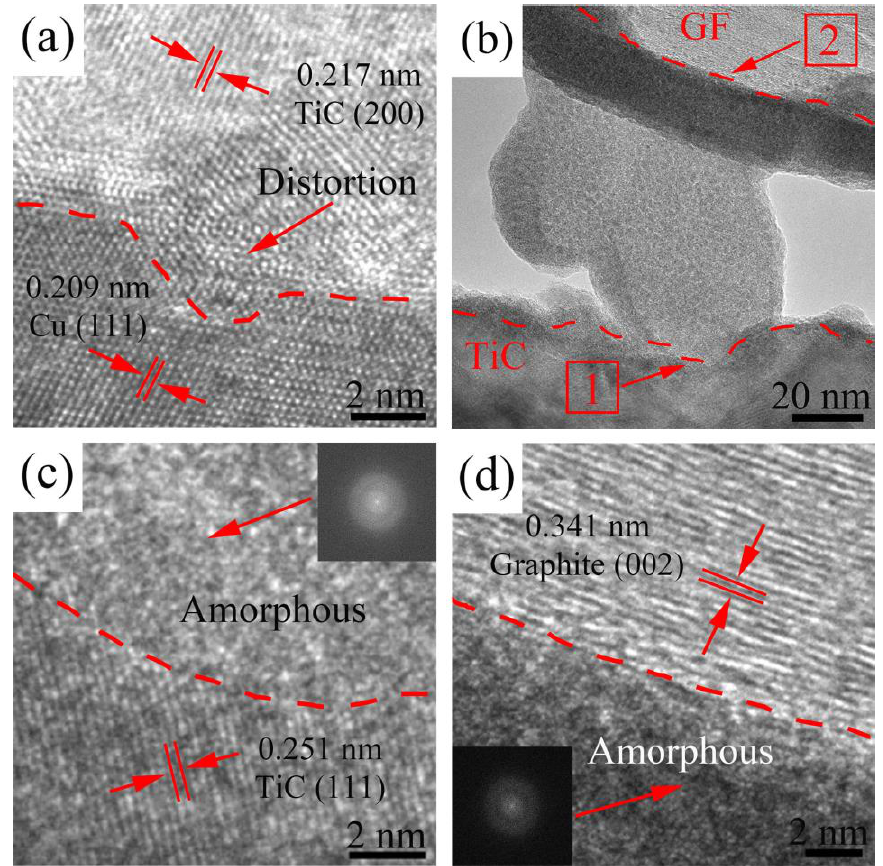
Figure 9. Interface characteristic of TiC-coated graphite flake/Cu composite: ( a ) HRTEM lattice image of Cu/TiC interface, ( b ) typical HRTEM image of TiC/GF interface, ( c ) HRTEM photo of interface 1 in ( b ), ( d ) HRTEM photo of interface 2 in ( b ).